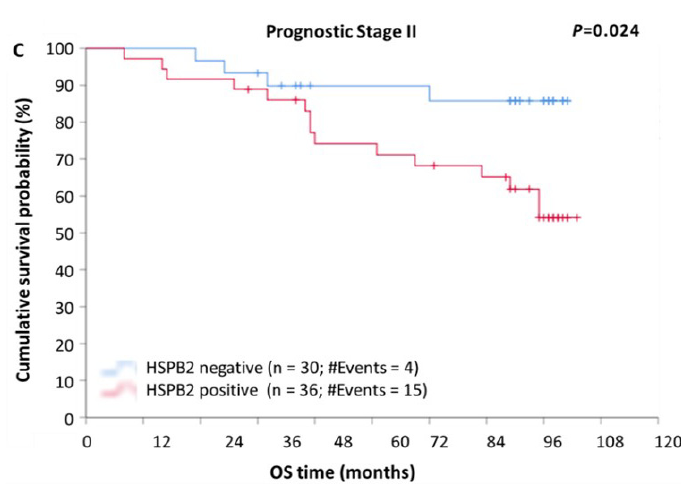
Figure 4. Stratified Kaplan–Meier survival curves for overall survival (OS) of BrCa patients, according to molecular subtype, anatomic, and prognostic stage. ( A ) Patients with triple-negative tumors being positive for HSPB2 mRNA expression had shorter OS time intervals than patients with HSPB2 -negative tumors. ( B ) Patients with HSPB2 -positive tumors of anatomic stage II had poorer OS than those with HSPB2 -negative tumors. ( C ) Patients with HSPB2 -positive tumors of prognostic stage II showed an increased probability of poorer OS compared to those with HSPB2 -negative tumors. p -value was calculated using the log-rank test.